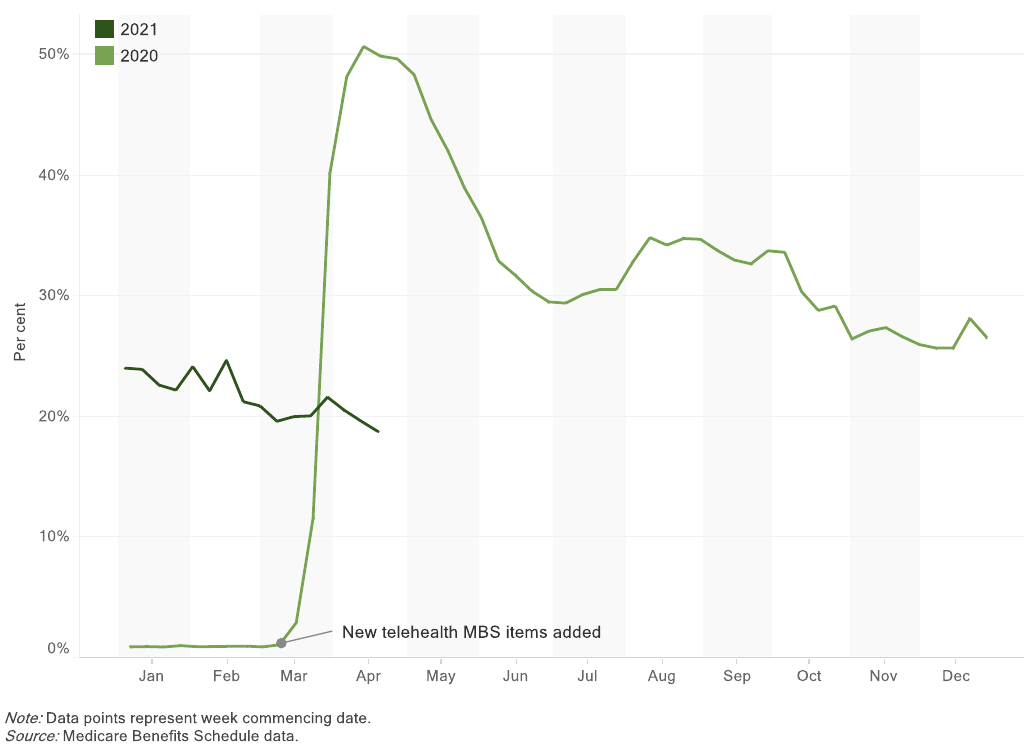
Figure 1. MBS mental health telehealth services (proportion of all MBS mental health services), January 2020–April 2021. (Website: